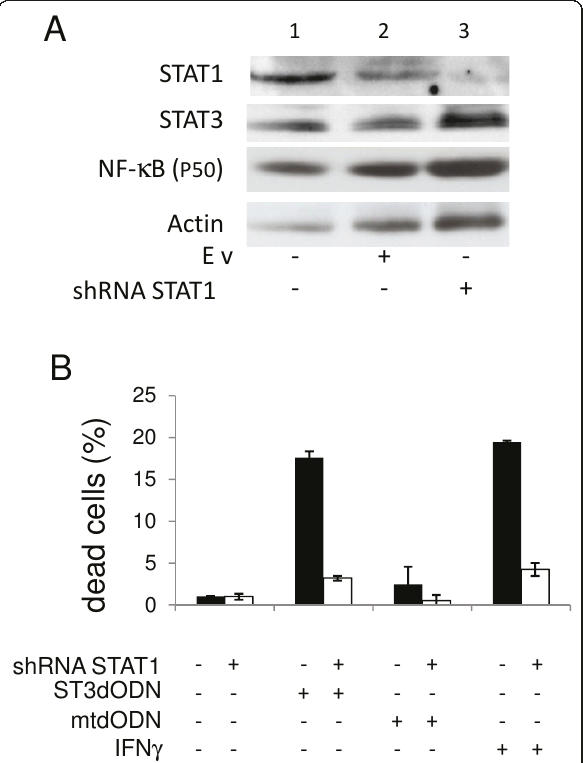
Figure 5 Involvement of STAT1 expression level in STAT3- decoy ODN-induced cell death . Colon carcinoma SW 480 cells transduced either with control virus (black histograms) or with STAT1-specific shRNA (white histograms). A : Detection of STAT1 by western blotting of control cells (1), cells transduced with an empty virus (Ev) (lane 2), and with a STAT1-specific shRNA lentivirus (3). Below are shown the detection of STAT3, the NF- (cid:1) B (p50 subunit) and actin in the same extracts. B : Detection of dead cells by trypan blue exclusion counting. Control non-treated (black histograms) and STAT1-shRNA-treated cells (white histograms) were either not treated or transfected with STAT3-decoy ODN (ST3dODN) (48 h), mutated STAT3-decoy ODN (mtdODN) (48 h) or IFN g (100 ng/ml, 48 h). Data are expressed in % of dead